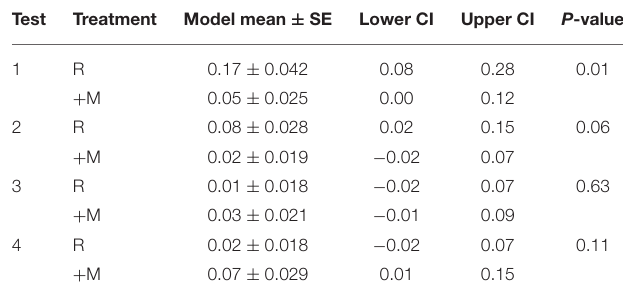
TABLE 4 | The model means of the audio tone (AT) ± standard error of mean (SE), upper and lower confidence interval (CI), and P- value of cows within Treatment across Tests.